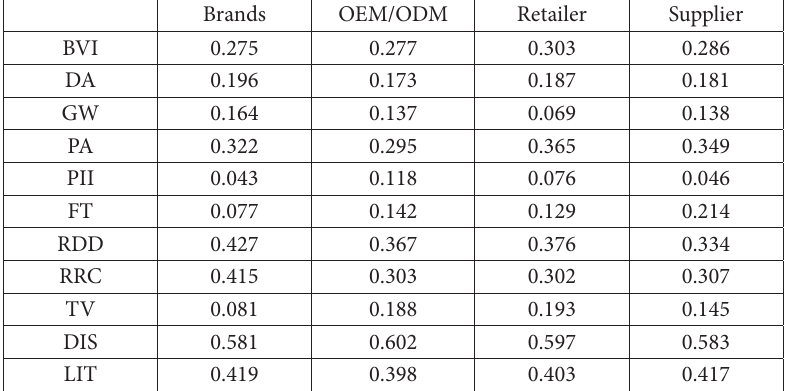
Table 1. Eigenvectors (weights) of 11 factors for alternatives